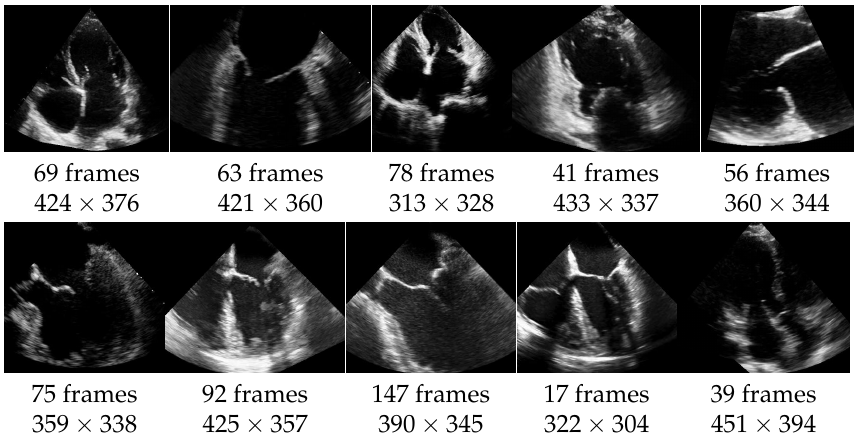
Figure 5. Dataset of 10 echocardiographic videos, with their number of frames and their spacial reso- lution.